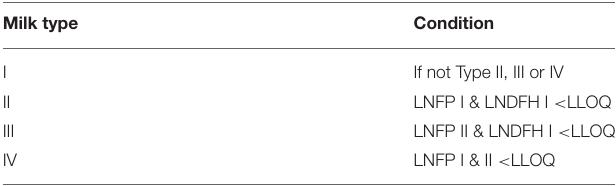
TABLE 1 | Basis on which human milk samples were classified to the different milk groups